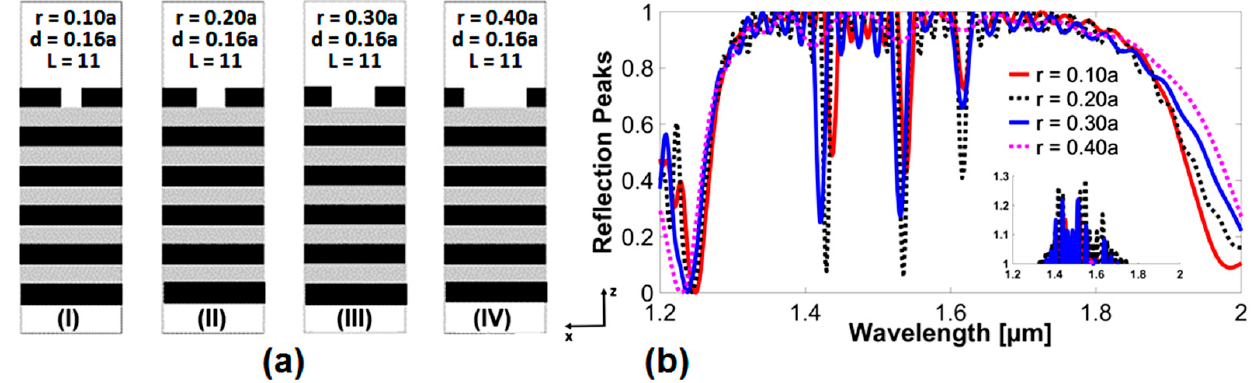
Figure 4. ( a ) 2D unit cell model of PhC structure with d extending up to the first layer and r varying as (I) 0.1 a , (II) 0.2 a , (III) 0.3 a , and (IV) 0.4 a . ( b ) Reflection spectra of the structure for r = 0.1 a , 0.2 a